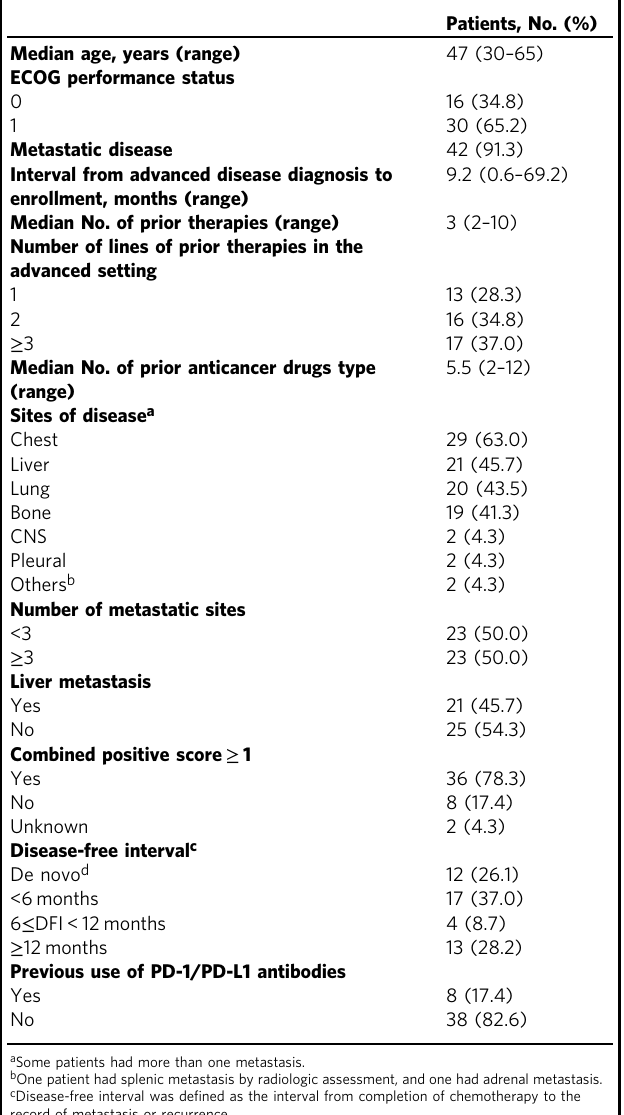
Table 1 Baseline characteristics of study population ( N =